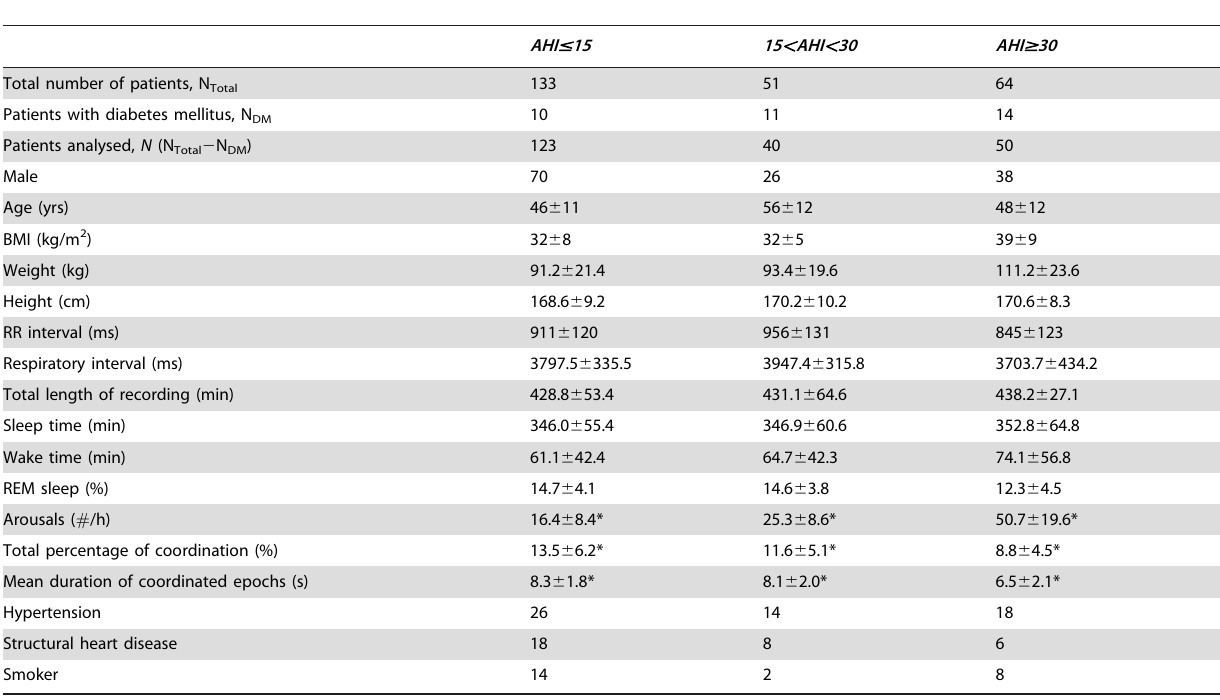
Table 4. Demographic data and overnight polysomnography findings in different groups of OSA